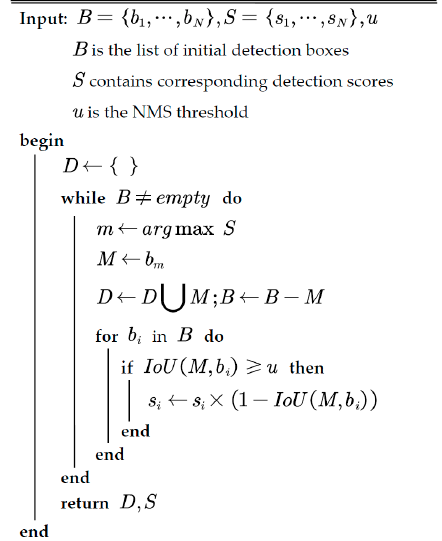
Figure 7. The pseudo-code of the Soft-NMS algorithm.